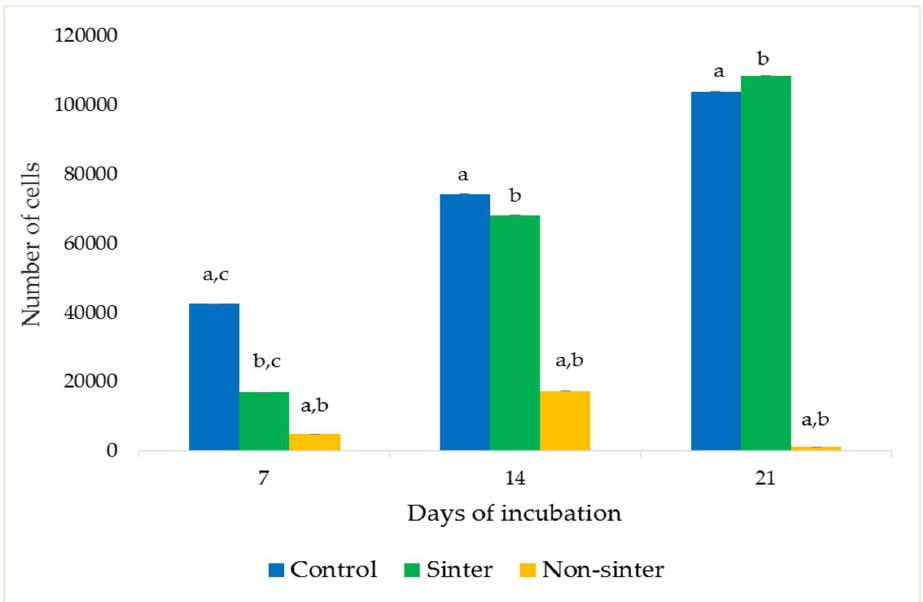
Figure 4. Viability of MC3T3-E1 preosteoblast cells seeded on sinter and nonsinter hydroxyapatite scaffolds. Cells without a scaffold were considered to be the control group. Same letter of a, b, c in each incubation day denotes significant differences within group ( p < 0.05).